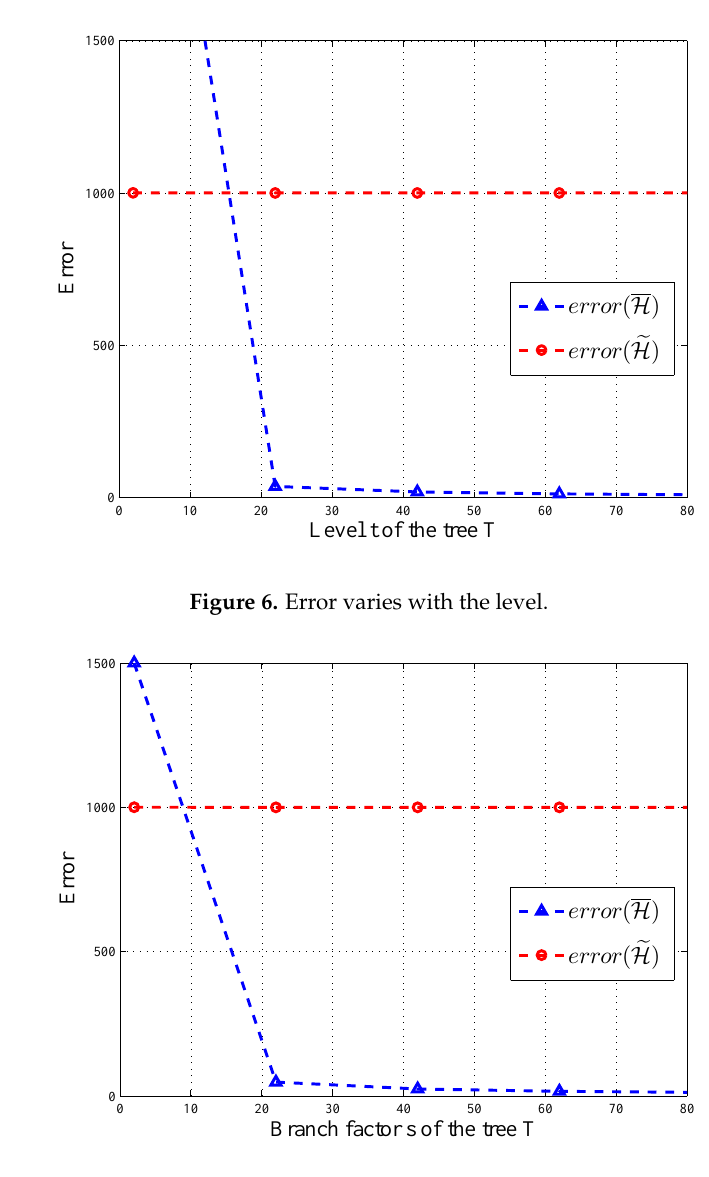
Figure 7. Error varies with the